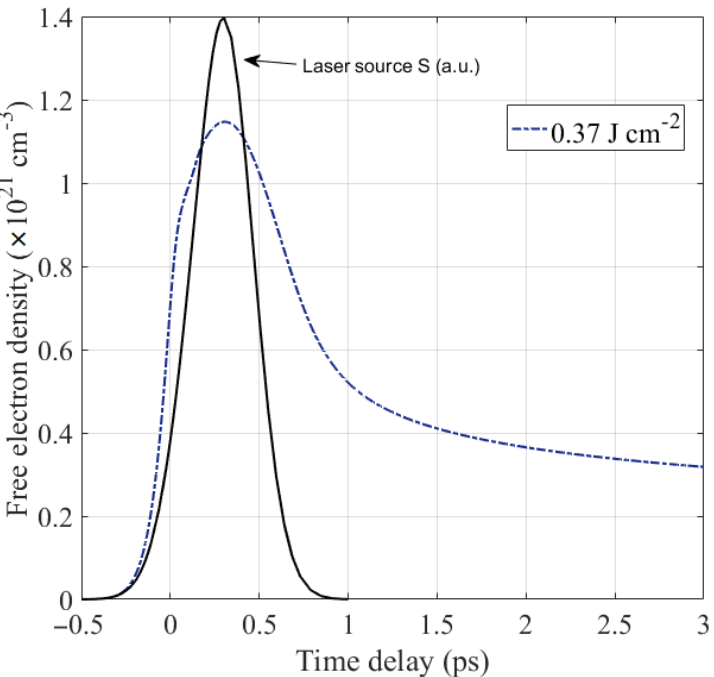
Figure 2. Free electron density evolution (blue dashed line) as a function of time for a Ge thin film under a single 300 fs laser pulse irradiation, at 1030 nm wavelength and a fluence of 0.37 J cm −2 . The laser pulse heat profile (black line) is plotted in arbitrary units.